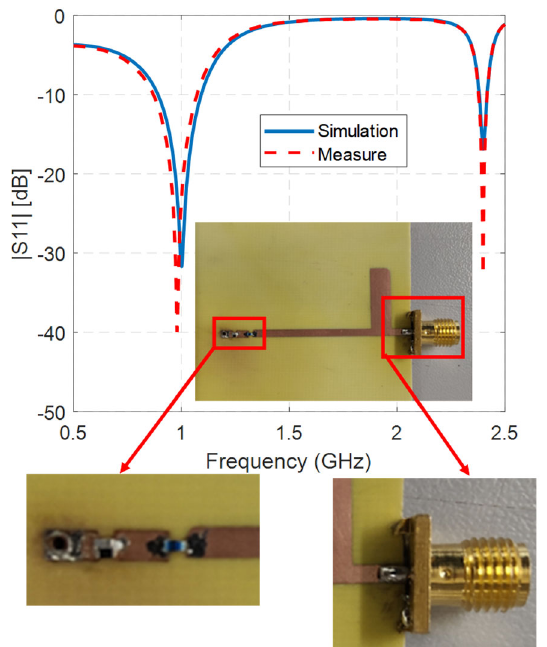
Figure 7. Simulative reflection coefficient of the compensated microstrip line matching network compared to the measurement of the realized circuit. The inset shows a picture of the realized circuit while the enlargements show details of the circuit ( left ) and connector ( right ).